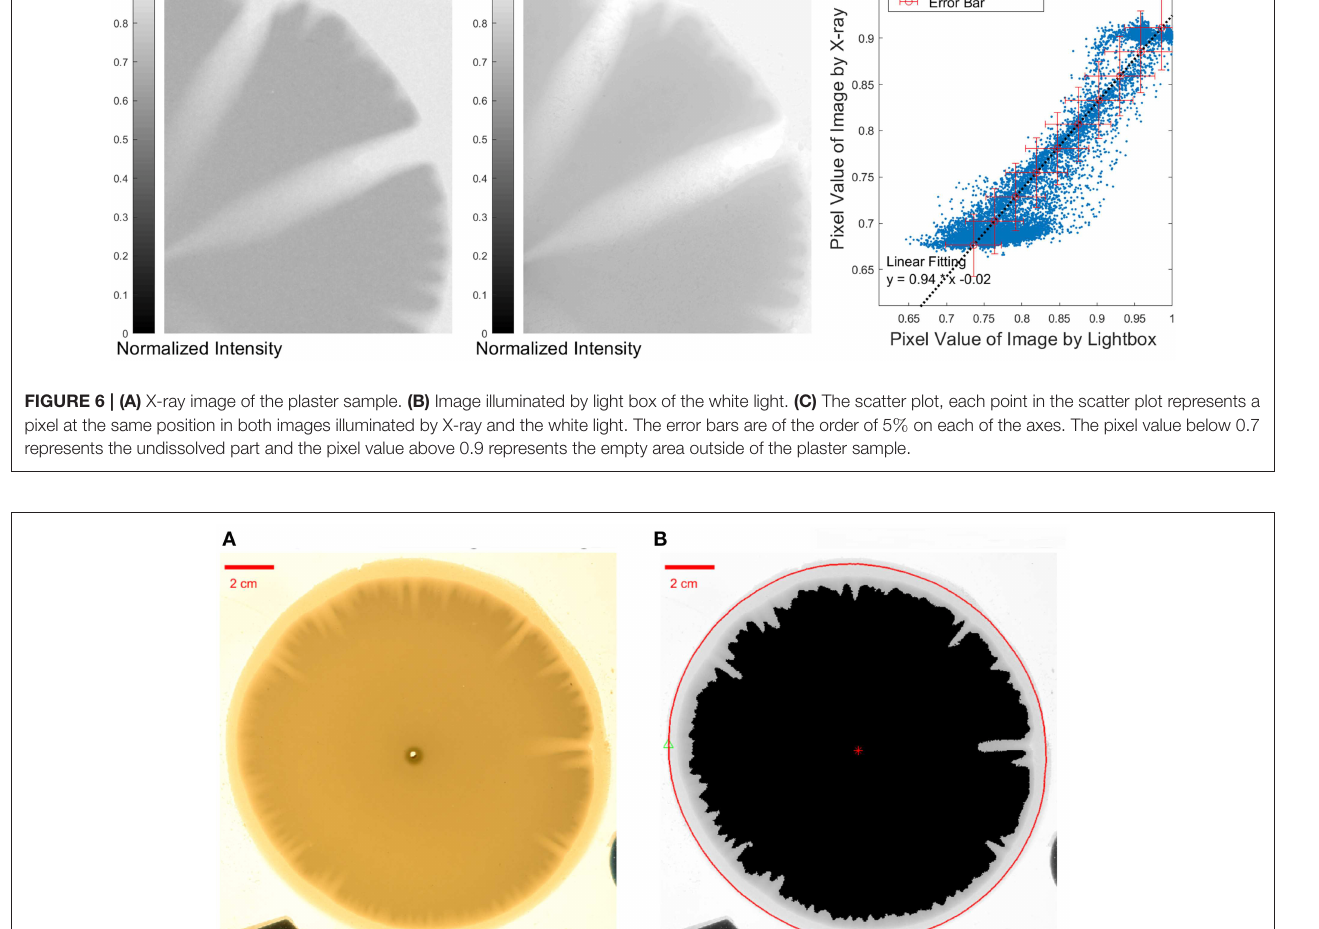
to parameterize the experimental data. Then we define a local dissolved part as S D ( p , t )